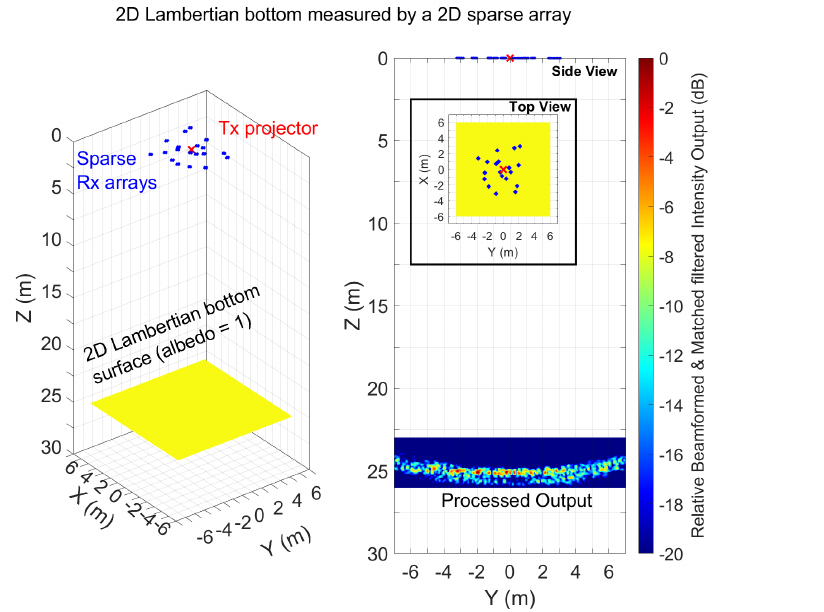
Figure A4. A simulated sparse array image of a 2D Lambertian seafloor. The array configurations are the same as those in Figure A3. A 2D seafloor effectively represents a spotlight-shaped transmit beam that is wide in both x and y directions. The 2D seafloor scattering increases sidelobe artifacts and further degrades image